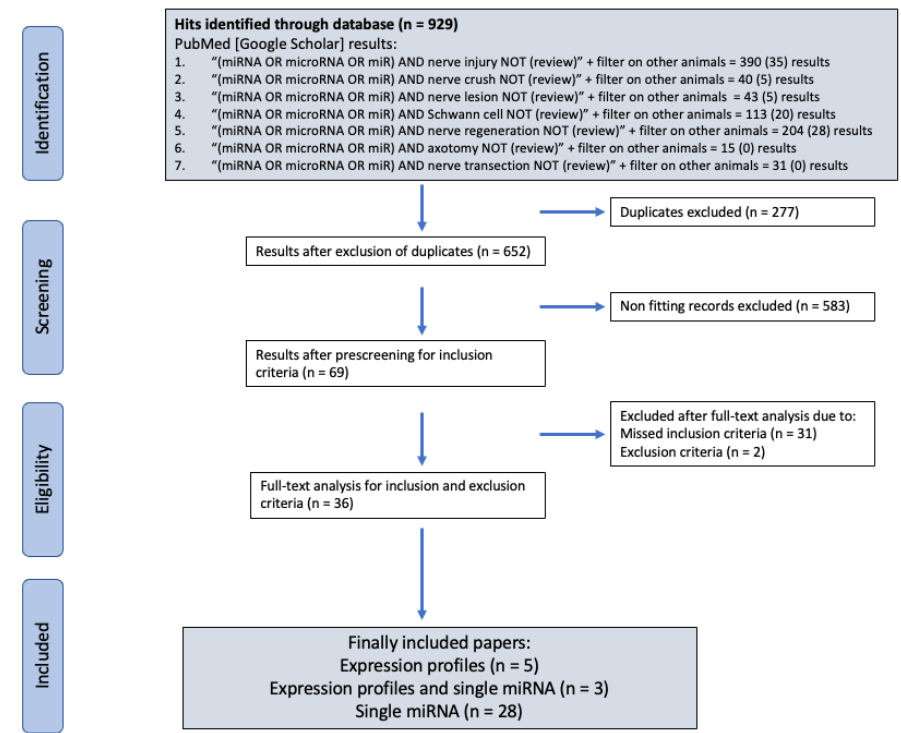
Figure 1. Overview search algorithm and results.